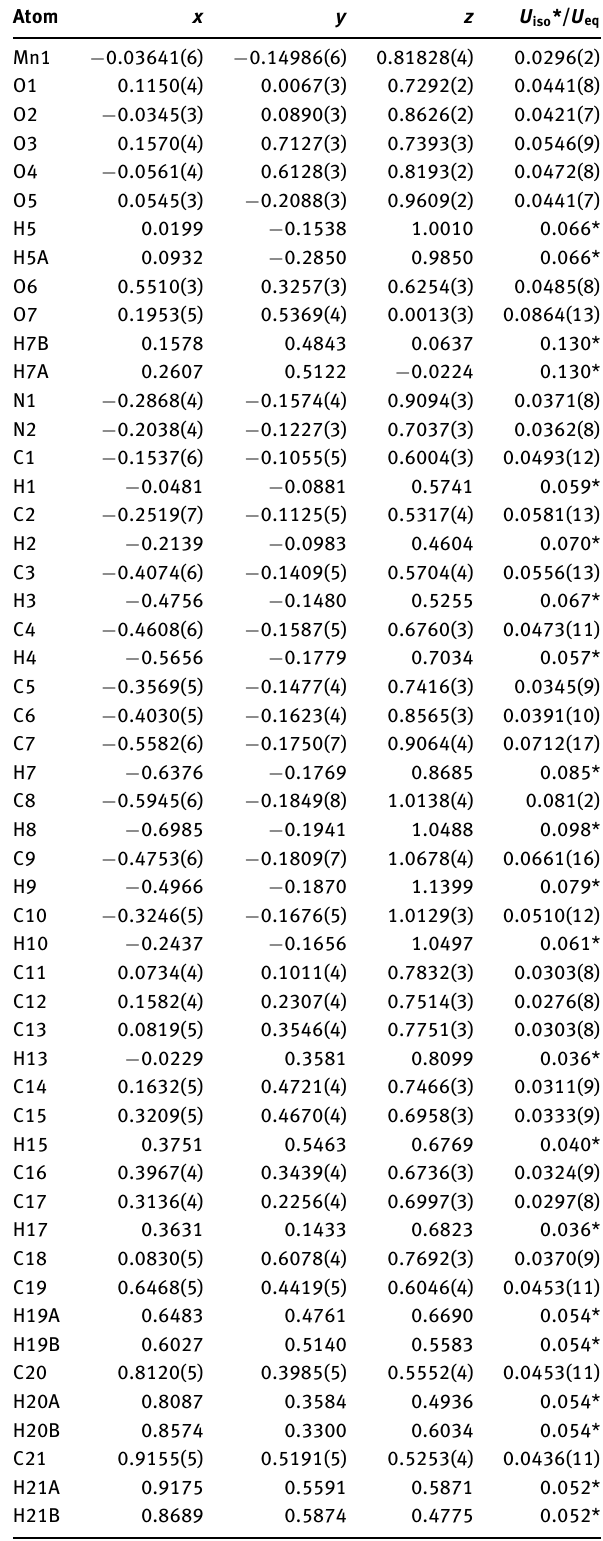
Table 2: Fractional atomic coordinates and isotropic or equivalent isotropic displacement parameters (Å 2